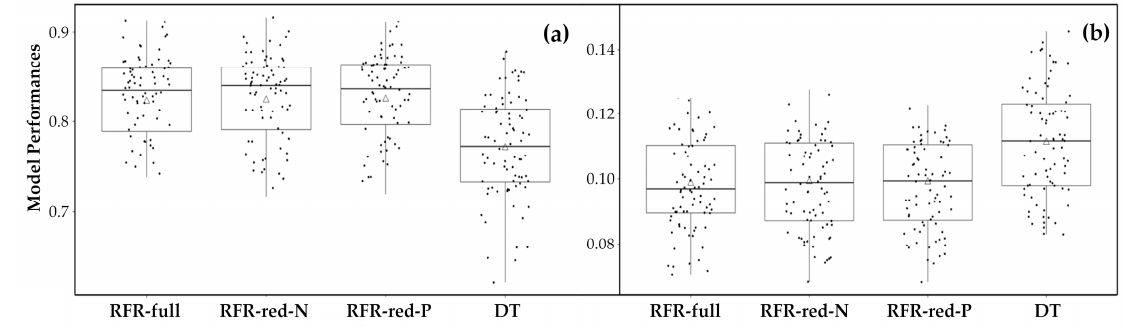
Figure 6. Jitter boxplots of predictive accuracies from 8 repetitions of 10-fold cross-validation. Each jitter point represents accuracy for one of the 80 validation rounds. Panel ( a ) and Panel ( b ) are predictive accuracies in terms of Pearson correlation coefficient and normalized root mean squared error, respectively. The triangles in each box represent the means of the model performances.